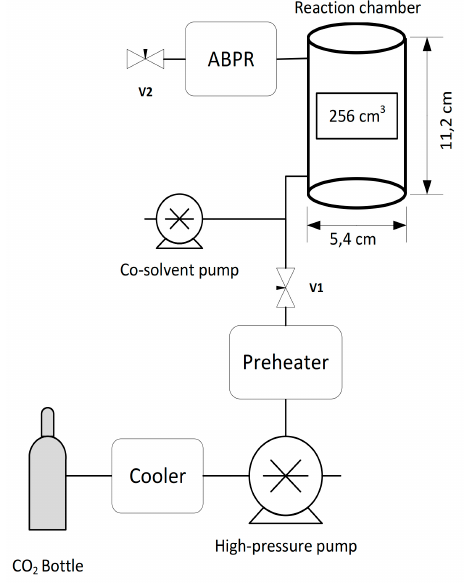
Figure 4. Schematic presentation of the scCO 2 apparatus.